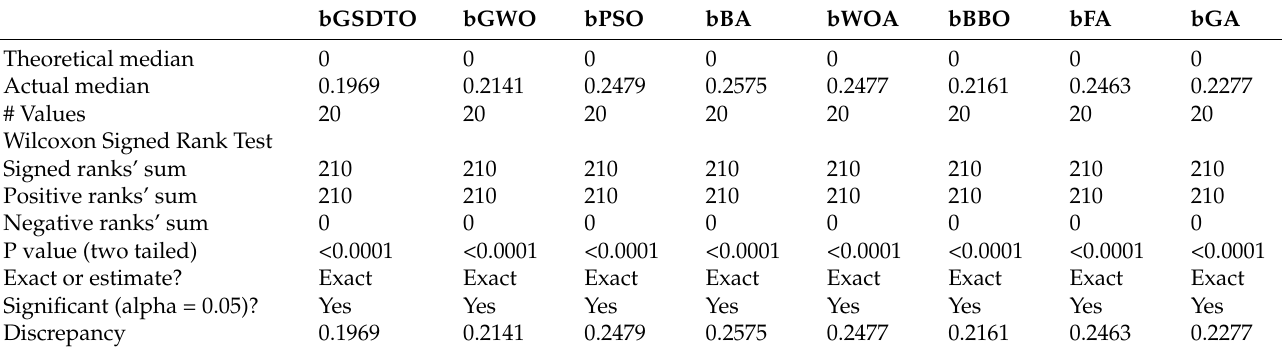
Table 8. Presented bGSDTO and compared algorithms Wilcoxon Signed-Rank test